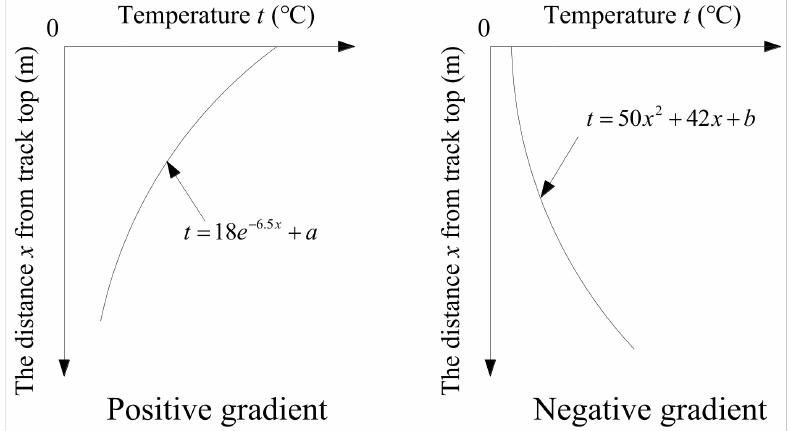
Figure 10. Vertical temperature load of ballastless